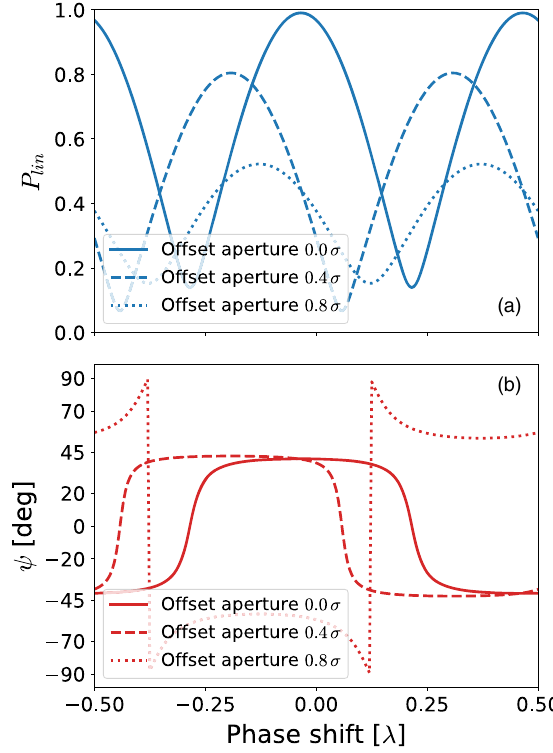
FIG. 9. Predicted degree of linear polarization (a) and direction (b) as a function of the phase between the two source fields, for different beam defining aperture position. The two fields have the same amplitude and have LV and LH polarization.